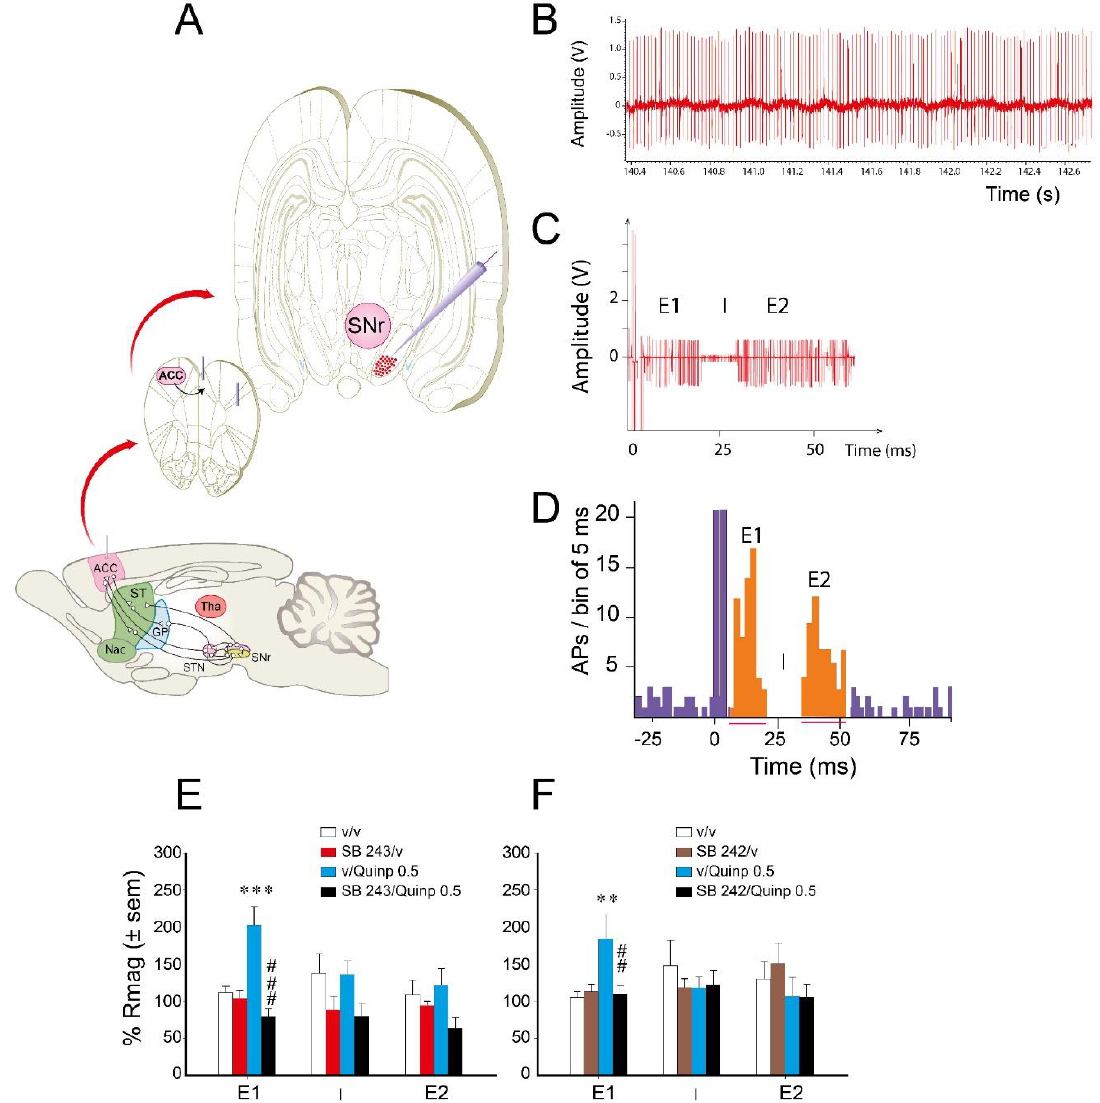
Figure 4. Effect of 5-HT 2C antagonism on the cortical responses of SNr neurons influenced by quinpirole. ( A ) schematic representation of cortical stimulation in the anterior cingulate cortex (ACC) and recording sites into the SNr. Each dot in the frontal slides represents a cell responding cells to the ACC stimulation. The responding neurons were located in the medial part of the SNr. The sagittal view of the brain reports the neuronal pathways linking the ACC to the SNr via the subthalamic nucleus, the striatum, and the GPe. ( B ) representative recording trace showing the firing rate of one SNr neuron before any injection (V, volt). ( C ) response of a SNr neuron to 50 ACC electrical stimulations (500 or 700 µ A) showing the increased number of action potentials in two periods during the 60 ms following the cortical stimulation and the disappearance of action potentials in-between the two phases of excitatory responses. ( D ) peristimulus time histogram (PSTH, number of action potentials (APs) per bin of 5 ms) representing the overall response of one SNr neuron to 50 cortical stimulations (0.3 Hz). It illustrates three sequential blocs of responses made by an early excitation (E1), an inhibition (I), and a late excitation (E2). The E1 and E2 phase are characterized by an increase of the number of AP per bin which is above the mean number of spikes before stimulation plus 50% (M + 50%). The inhibitory response corresponds to the time interval during which no spike was recorded. ( E , F ) effect of the 5-HT 2C antagonists SB 243213 ( E ) or SB 242084 ( F ) on the response magnitude (Rmag) of each phase of SNr neuron responses evoked by ACC stimulation with or without quinpirole (Quinp, 0.5 mg/kg). Data correspond to the mean ± S.E.M. of Rmag (in percentage of initial response magnitude, Rmag initial) for E1 ( n = 7–11 rats per group), I ( n = 7–11